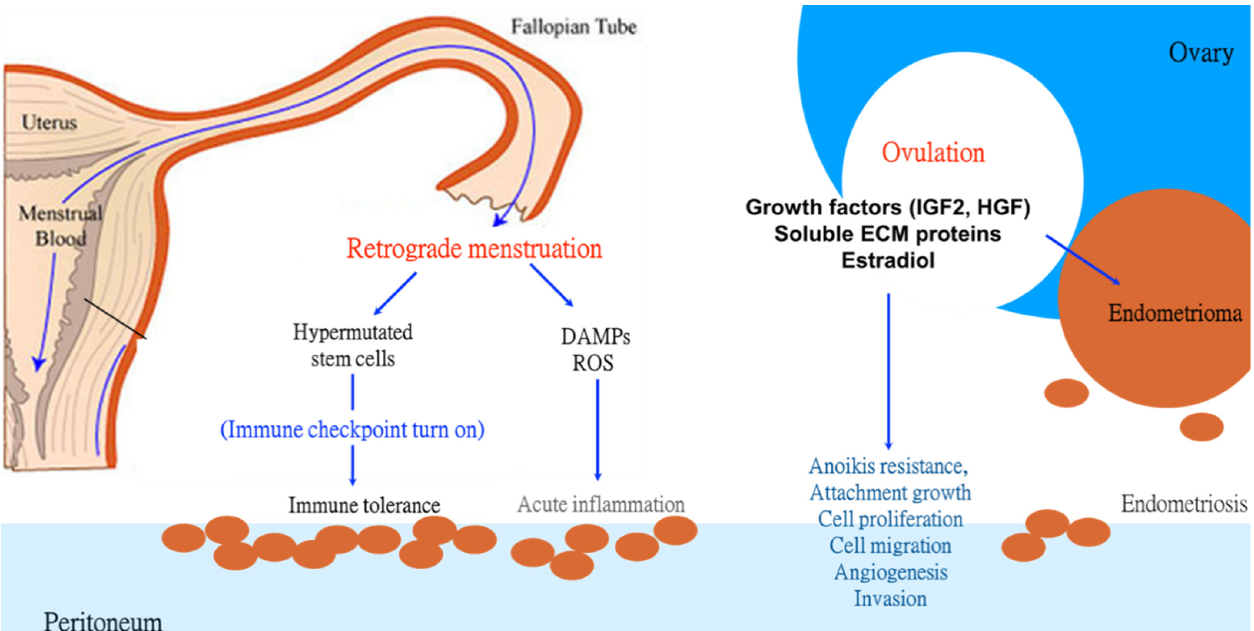
Figure 4. The double engines and single checkpoint theory of the genesis of endometriosis. Ret- rograde menstruation sources stem cells from the broken-down endometrial tissue. It also sup- plies immunogenic and tissue-damaging substances, such as damage-associated molecular